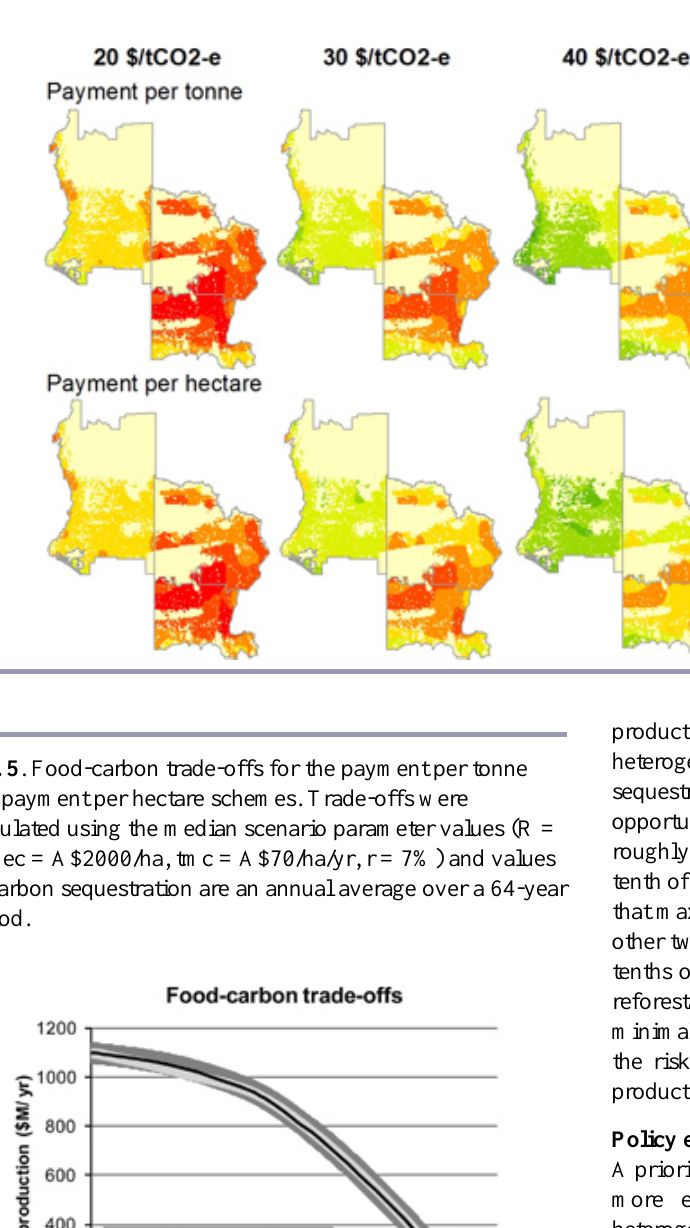
Fig. 4 . Spatial distribution of net economic returns (annualized) to reforestation under the payment per tonne and payment per hectare schemes for a range of carbon prices using the median scenario parameter values (R = 0.8, ec = A$2000/ha, tmc = A$70/ha/yr, r = 7%).